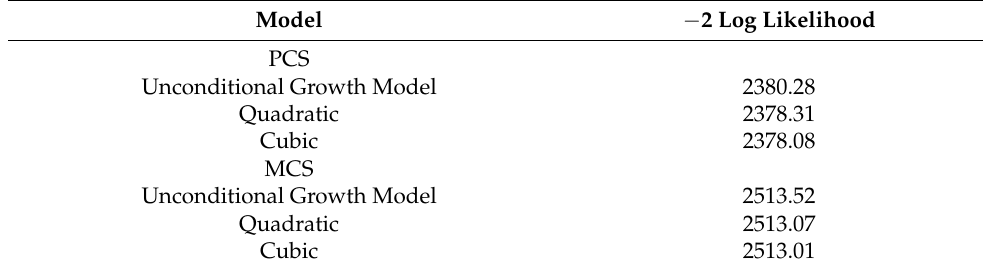
Table 2. Model fit for the Physical Component Summary (PCS) and Mental Component Summary (MCS) trajectories over